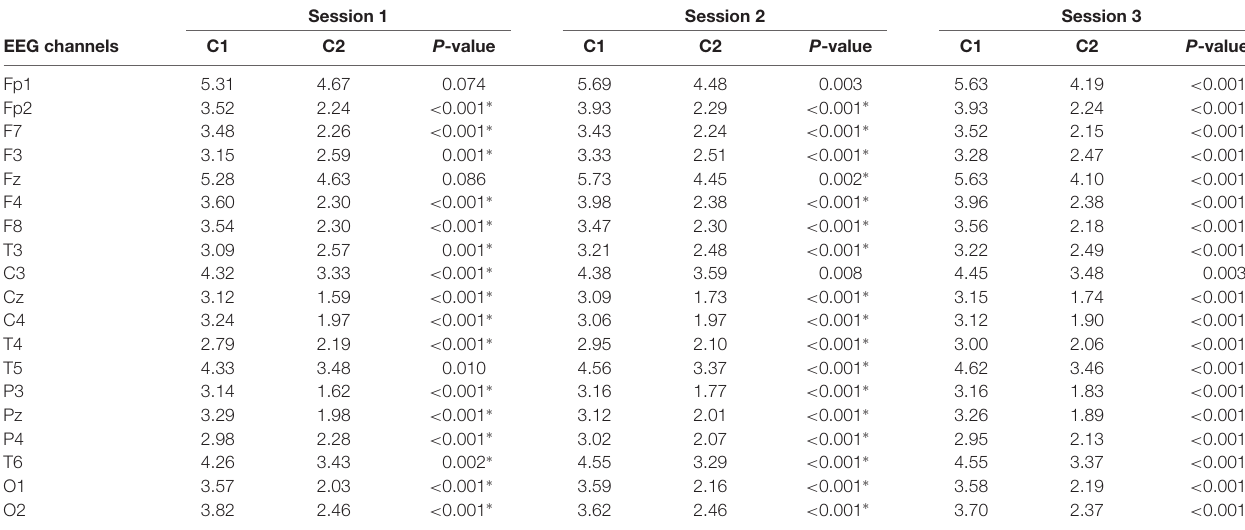
TABLE 2 | Distinction in log-transformed EEG delta band power between both clusters across 19 EEG channels among the three sessions. Session 1 EEG